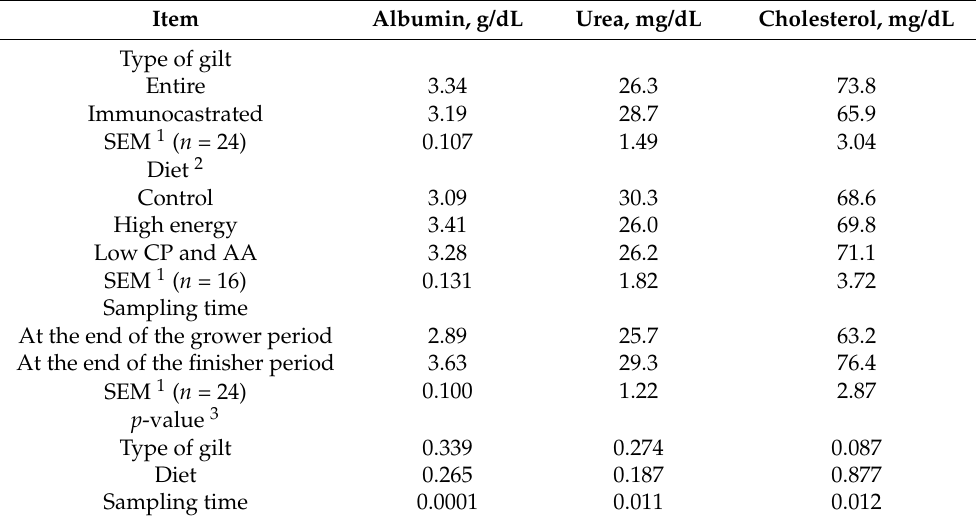
Table 3. Impact of immunocastration and diet on serum metabolites (least square means) of